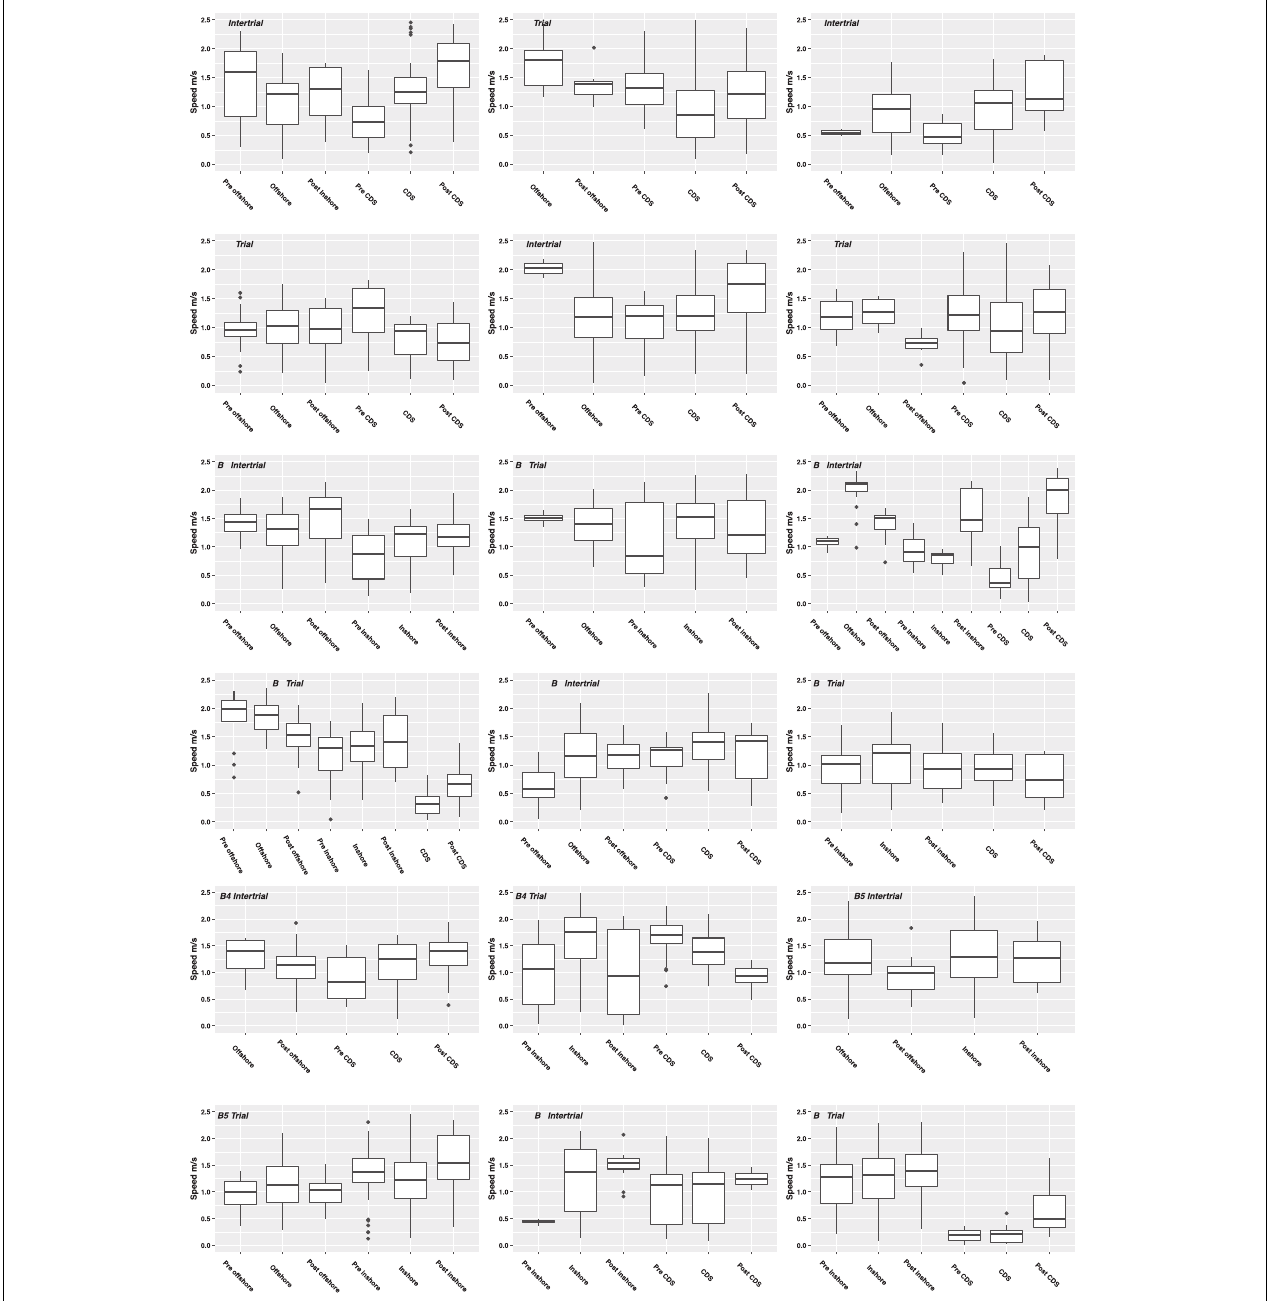
FIGURE 8 | Boxplots of the horizontal speed of individual whales during intertrials ( upper nine plots ) and trials ( lower nine plots ) in different topographical context [inshore, offshore, or in cul-de-sac (CDS)]. The thick line in the middle is the median, the box identifies the first and third quantiles, the vertical line show the range of data, and dots indicate